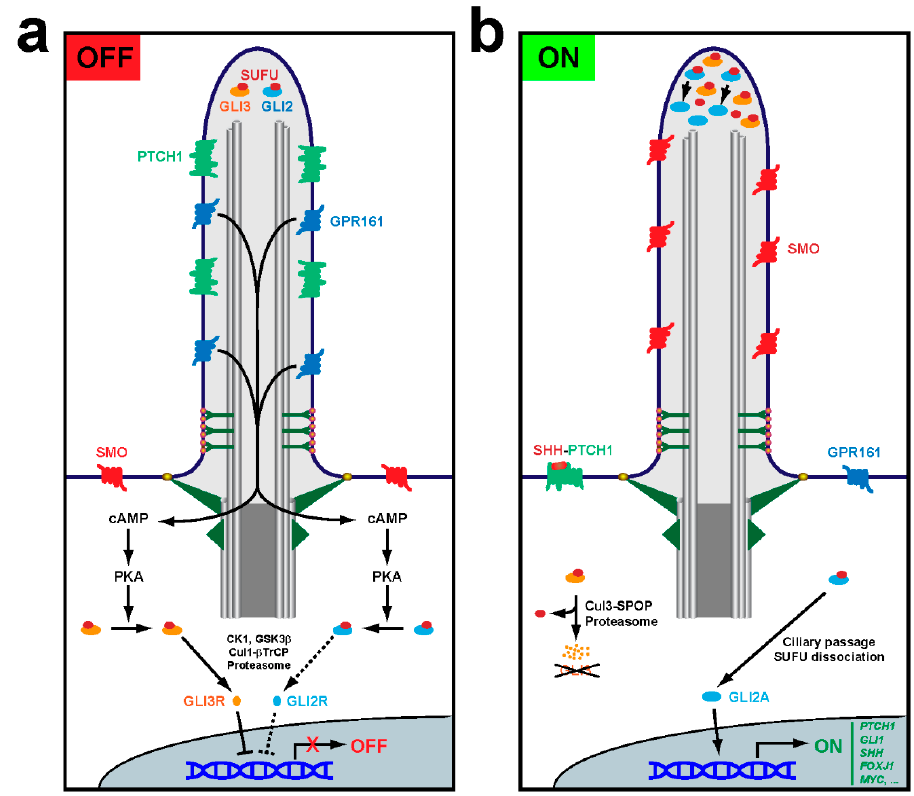
Figure 2. Primary cilia control Hedgehog pathway output. ( a ) In the OFF mode, Hh ligands are absent and their receptor PTCH1 accumulates inside cilia, keeping SMO outside. GPR161, a constitutively active G s protein-coupled receptor, promotes ciliary production of cAMP, which activates protein kinase A (PKA) at the ciliary base. PKA then phosphorylates GLI2 and GLI3, the transcription factors mediating Hh pathway output. Both factors interact with their repressor SUFU, with which they travel to and from the ciliary tip. Such travel is required for PKA-dependent regulation of GLI2 and GLI3. Phosphorylation by PKA primes GLI2 and GLI3 for phosphorylation by casein kinase 1 (CK1) and glycogen synthase kinase 3 β (GSK3 β ). For GLI3, this leads to ubiquitination by the Cul1- β TrCP (cullin1- β -transducin repeats-containing protein) E3 ubiquitin ligase and subsequent proteasome-dependent partial proteolytic cleavage to release SUFU and form GLI3R, a transcriptional repressor. GLI2 can also be processed into GLI2R, but this is inefficient because GLI2, unlike GLI3, lacks a processing-determinant domain (PDD). Thus, most phosphorylated GLI2 remains SUFU-bound and inactive. When cilia are absent or dysfunctional, unstimulated cells cannot form GLI3R, and thus its target genes are derepressed. This is the molecular mechanism underlying certain manifestations of ciliopathies, like polydactyly. ( b ) In the ON mode, Hh ligands like SHH bind PTCH1, removing it from cilia and enabling ciliary accumulation and activation of SMO. This leads to GPR161 ciliary exit, which stops cAMP synthesis and prevents PKA activation. In the absence of PKA phosphorylation, GLI3 is fully degraded by the proteasome via Cul3-SPOP (Cullin3-Speckle-type POZ protein)-